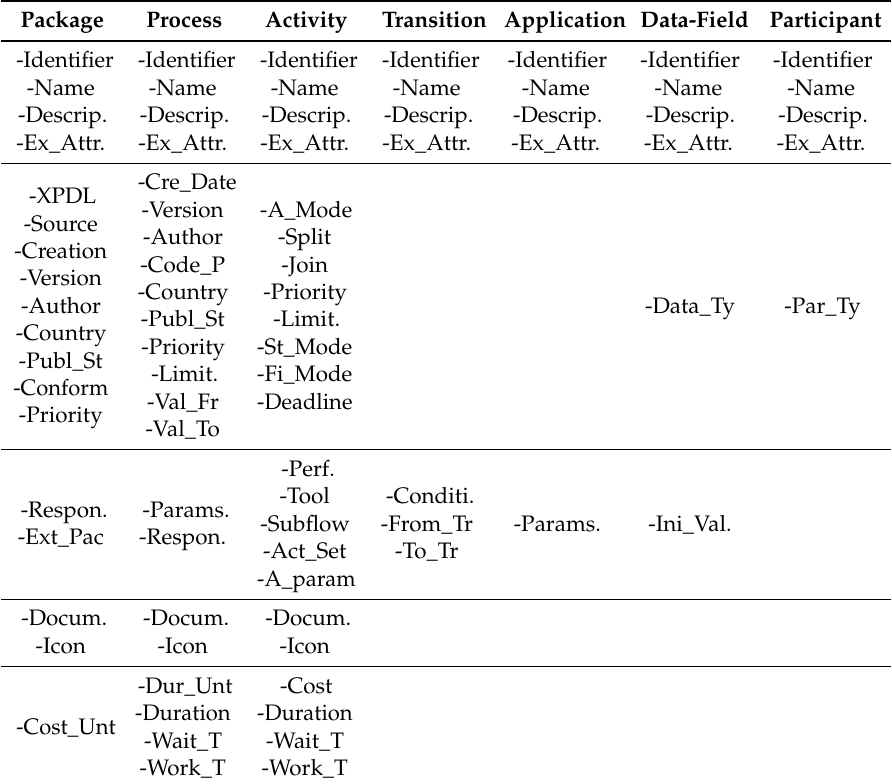
Table 1. Structural attributes in the XML process definition